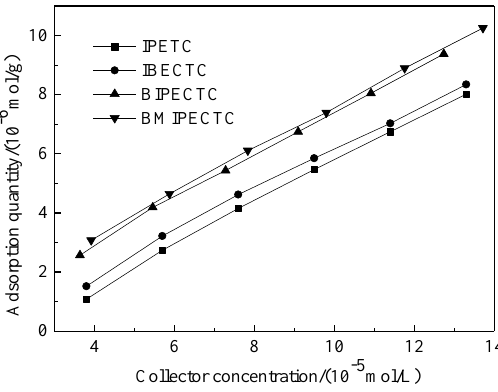
Figure 8. Adsorption quantity function of pH.